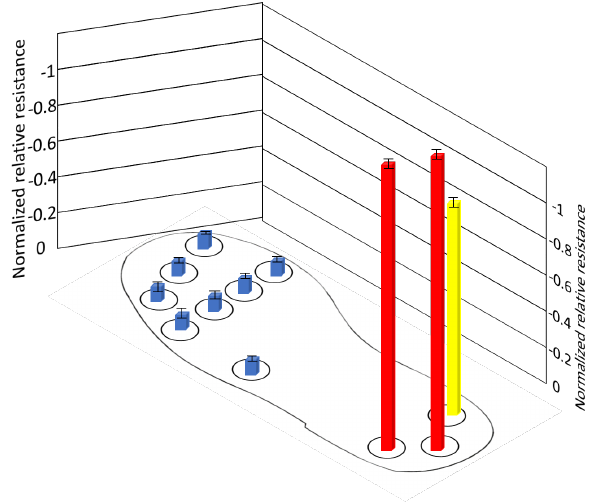
Figure 13. Normalized resistance of sensors during position A.